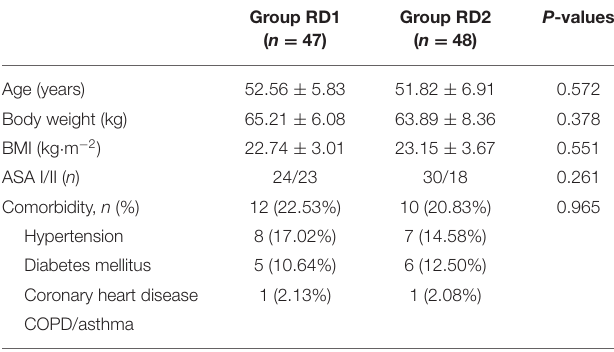
TABLE 1 | Comparison of demographic data between the two groups.